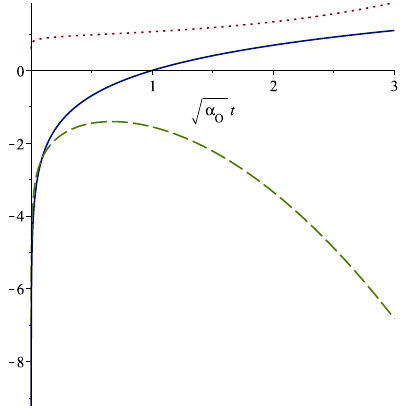
Figure 7 . The scale factor e (cid:10) (red, dotted), the unstable homogeneous tensor mode (blue) and the scalar (cid:12)eld (cid:30) (green, dashed) as a function of section